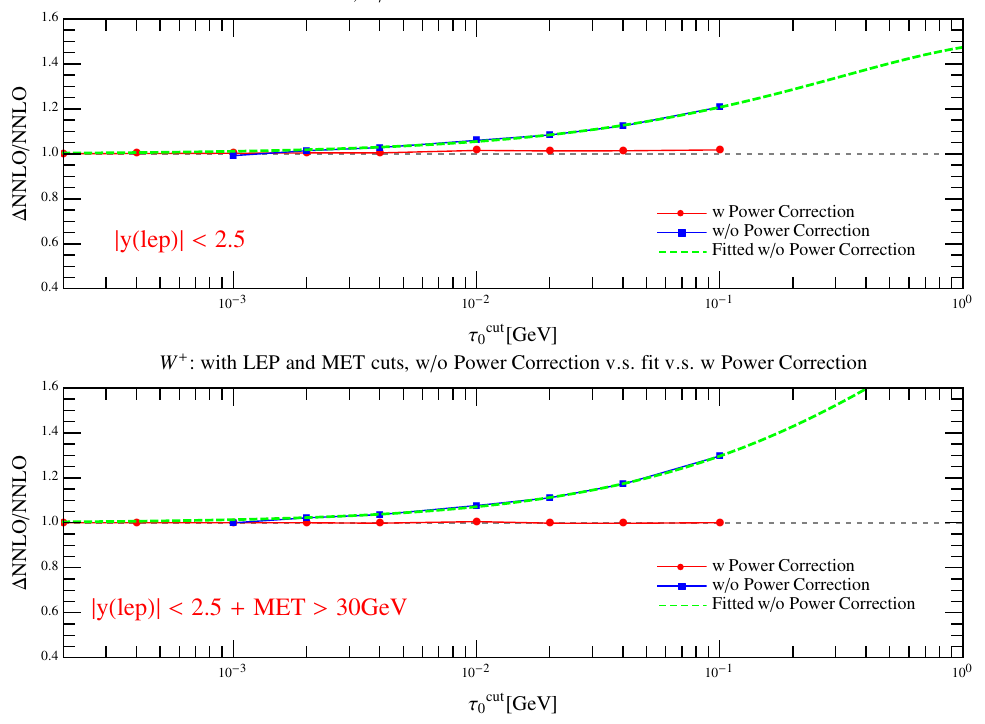
Figure 3 . The di(cid:11)erence between the NNLO coe(cid:14)cients for Z -boson and W + -boson production with lepton and missing energy cuts at the LHC obtained using N -jettiness subtraction with and without power corrections, normalized to the exact NNLO